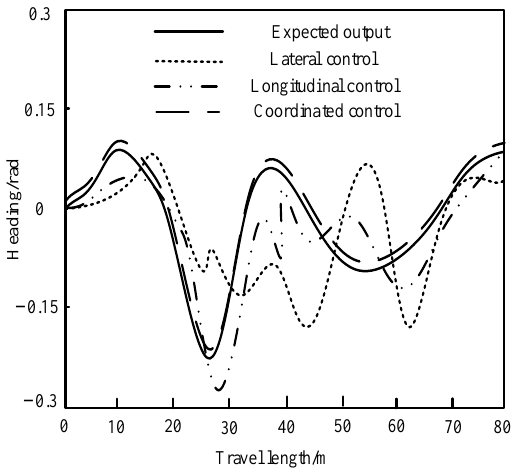
Figure 7. Results of heading angle control.